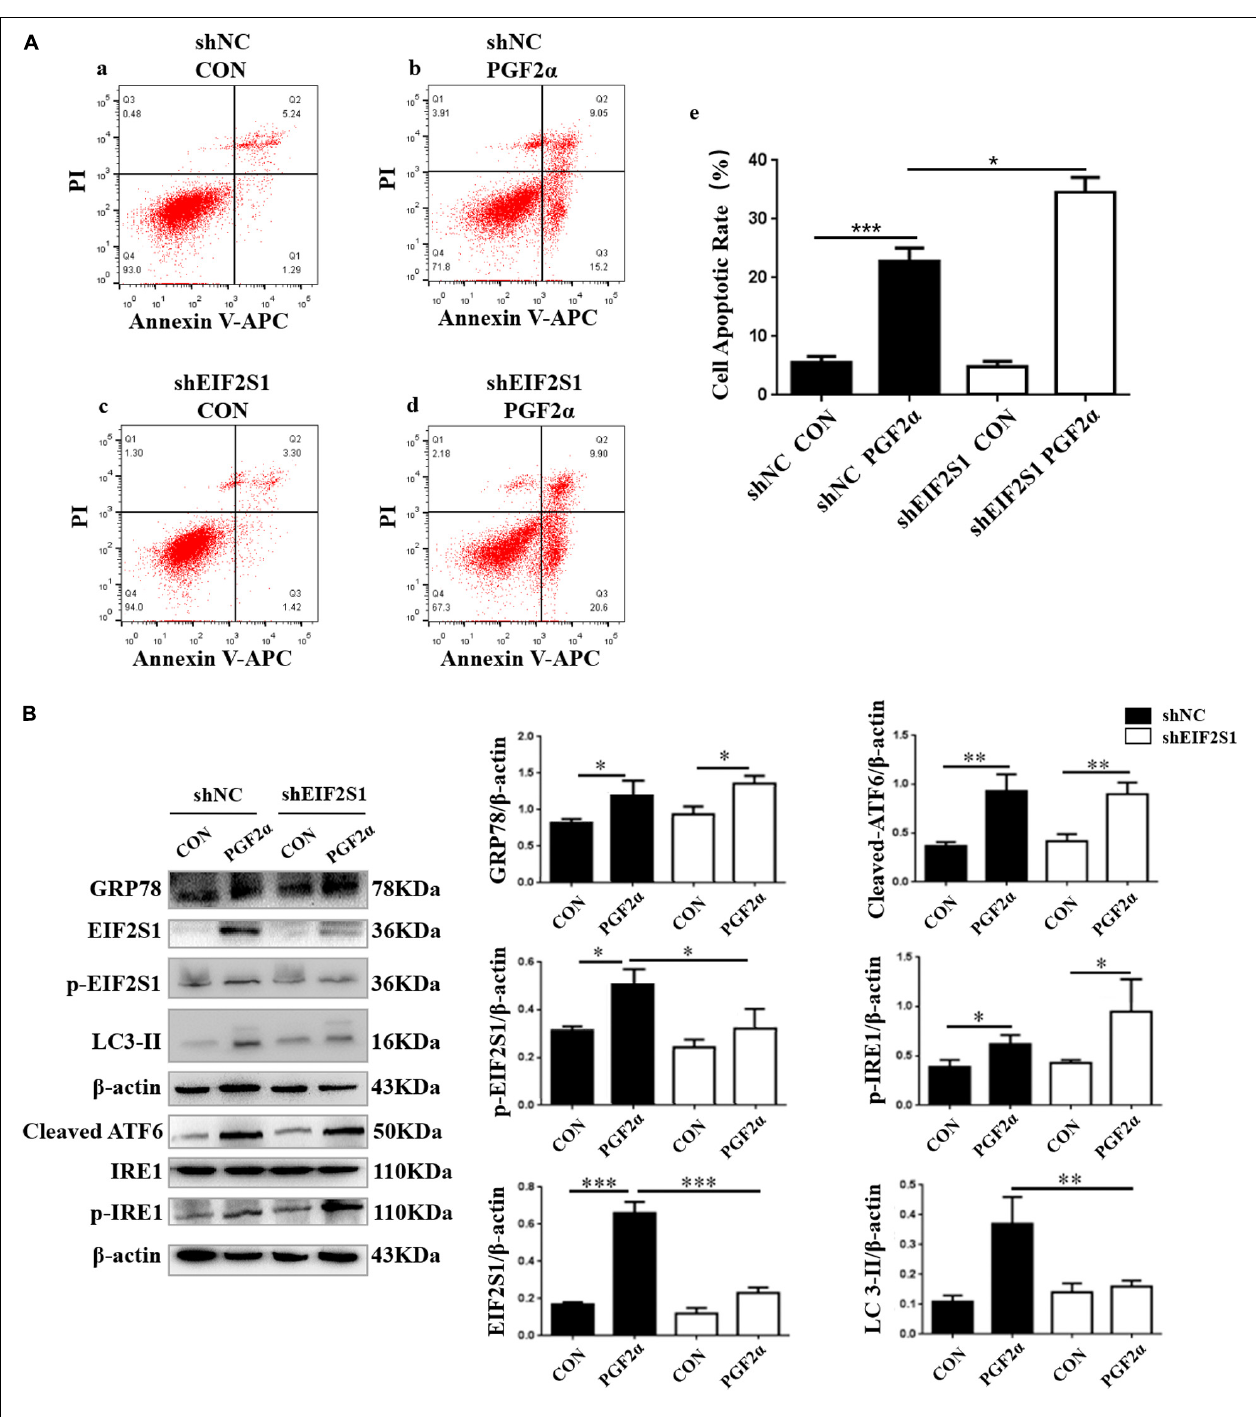
FIGURE 5 | Effect of EIF2S1 knockdown on goat luteal cell apoptosis, ER stress, and autophagy under PGF2 α treatment. (A) Cells cultured in medium with PGF2 α (1 µ M) (b,d) or isopycnic PBS (a,c) for 24 h are stained with annexin V-APC/PI and analyzed by flow cytometry. (e) The histogram shows the apoptotic rate displayed in (a–d) from three separate experiments. (B) The changes in the expression of p-EIF2S1, ATF6, LC3, and p-IRE1 under EIF2S1 knockdown. The goat luteal cells infected with a lentivirus specific for EIF2S1 and a negative lentivirus (shNC) for 48 h. Then, cells are treated with PGF2 α (1 µ M) for 24 h, total protein from LCs were subjected to western blot analysis. Data in the bar graph represent the mean ± SEM of three independent experiments ( N = 3). Means are compared with one-way ANOVA combined with Tukey’s post hoc tests. ∗ p < 0.05, ∗∗ p < 0.01, ∗∗∗ p < 0.001.